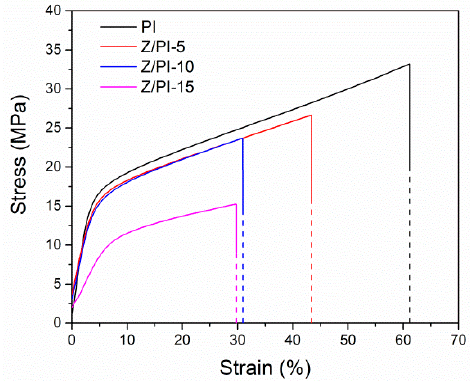
Figure 3. The stress–strain curves of different separators.